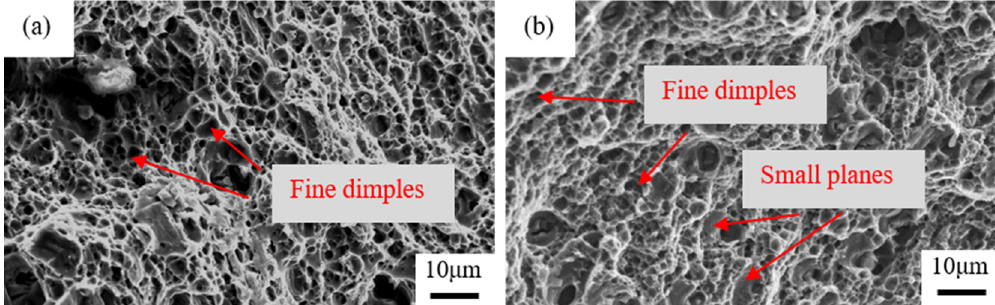
Figure 9. Fracture surfaces of the two alloys aged for 8 h at 210 °C: ( a ) Al-4Mg alloy, ( b ) Al-4Mg-0.6Ag alloy.